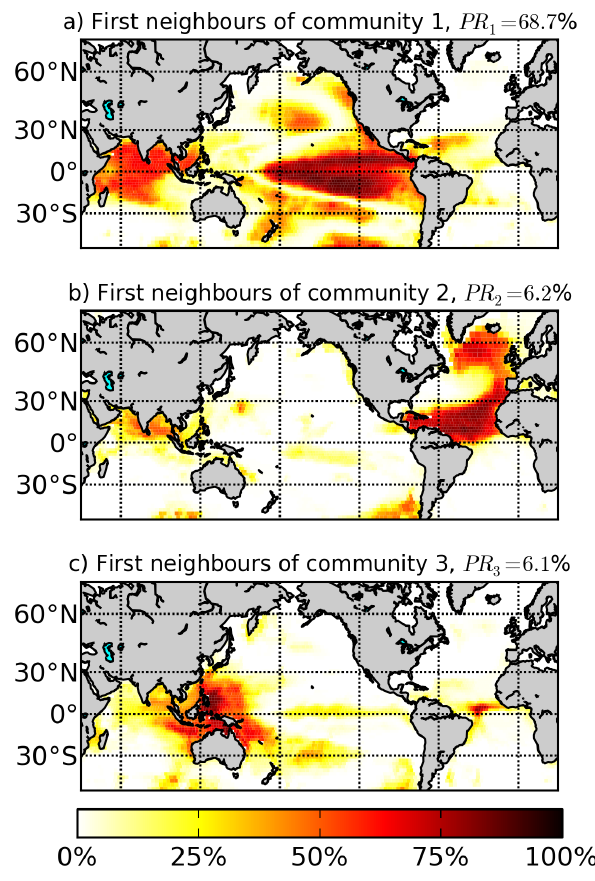
Fig. 5. First neighbours map of communities (a) #1, (b) #2, and (c) Fig. 5: First neighbours map of communities (a) #1, (b) #2, and (c) #3 in the H-SST network. For #3 in the H-SST network. For each node, the color scale indicates each node, the color scale indicates the percentage of the nodes in the community to which that node the percentage of the nodes in the community to which that node is is connected.